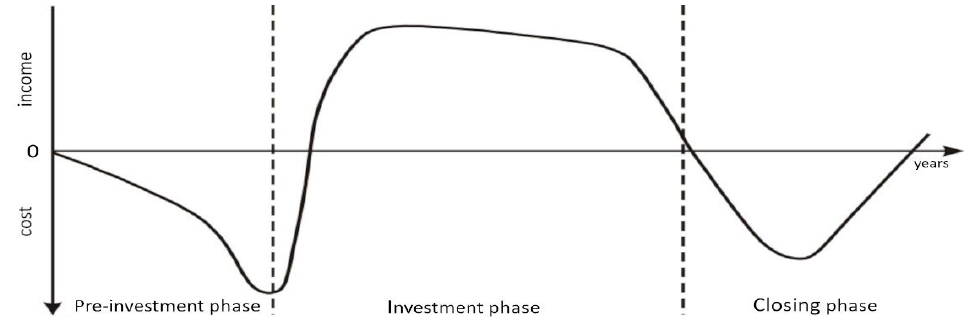
Figure 1. Schematic diagram of financial flows during the entire mine life cycle (own material based on Paulo [9]). on Paulo